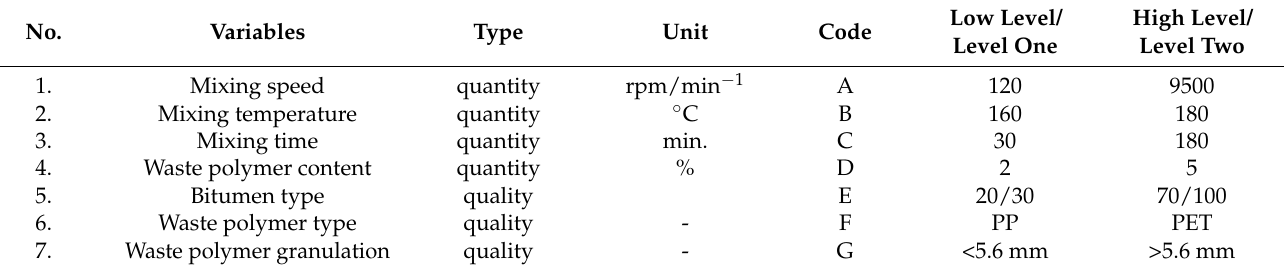
Table 3. Variables in the Plackett–Burman experimental design